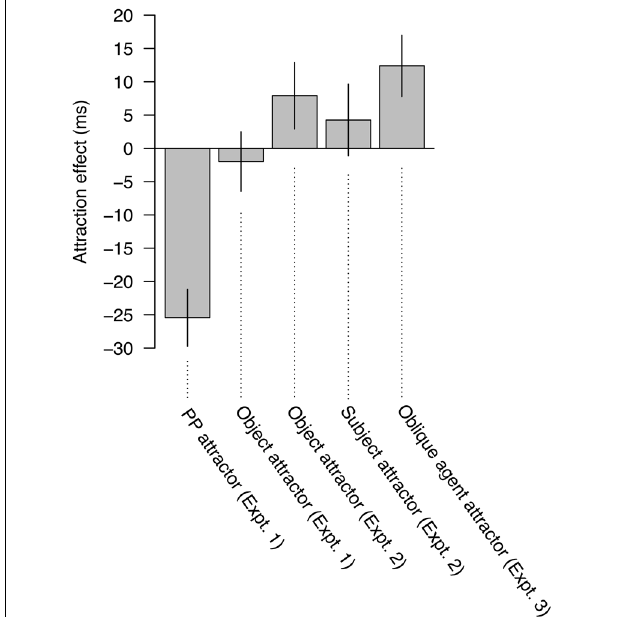
FIGURE 6 | Comparison of the profiles observed in Experiments 1–3 for PP, subject, object, and oblique arguments. The attraction effect for each attractor position was calculated by subtracting the RTs for the ungrammatical plural attractor condition from the ungrammatical singular attractor condition in the first spillover